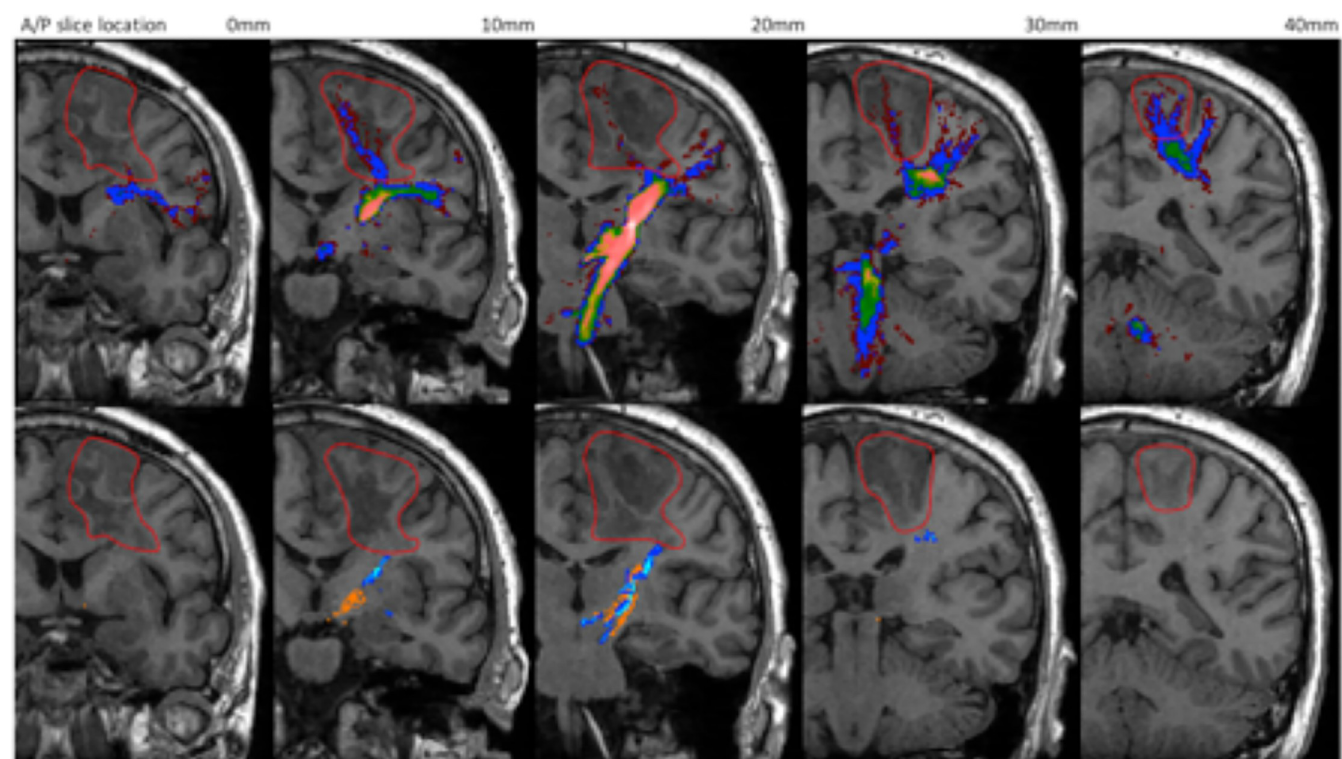
Fig 10. Tractography of the CST for patient 2. Top row: Prob 0.005 (red), Prob 0.01 (dark blue), Prob 0.025 (green), Prob 0.05 (yellow), Prob 0.075 (pink). Bottom row: CSD-stream (blue), STEALTH (orange). Lesion is outlined in red.